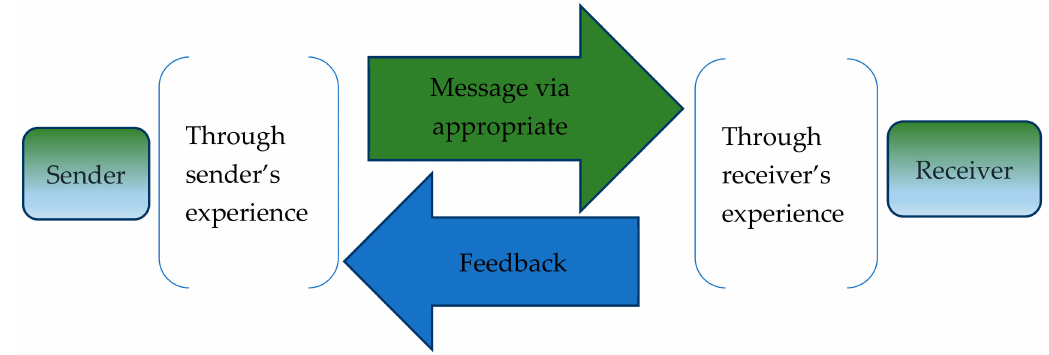
Figure 2. Schramm’s [18] communication model with